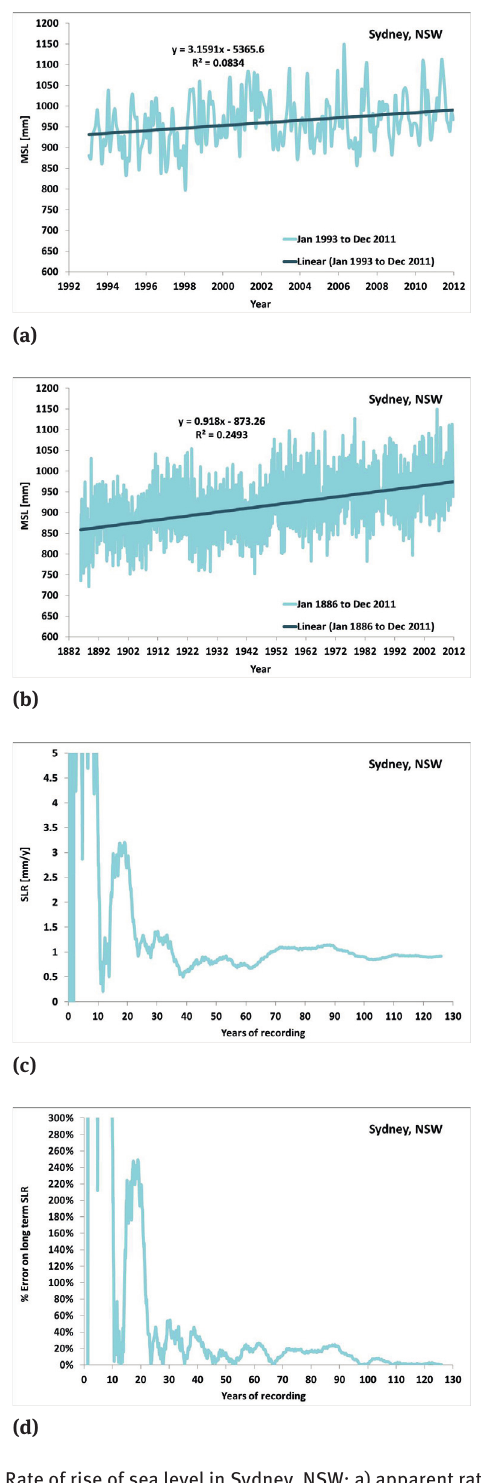
Fig. 2. Rate of rise of sea level in Sydney, NSW: a) apparent rate of rise of sea level obtained by focusing on the last 19 years of data starting from a valley of the peak and valley multi-decadal oscilla- tion; b) correct value obtained by using all the data covering almost 130 years; c) present rate of rise of sea levels as a function of the time window considered; d) error on the estimation of the long term trend based on the length of the record. Further details in